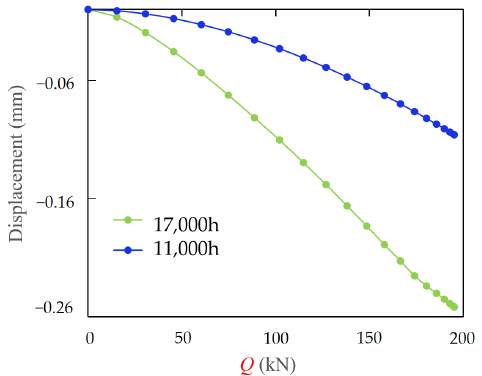
Figure 9. Contact sti ff ness between main roller and outer ring at di ff erent times.